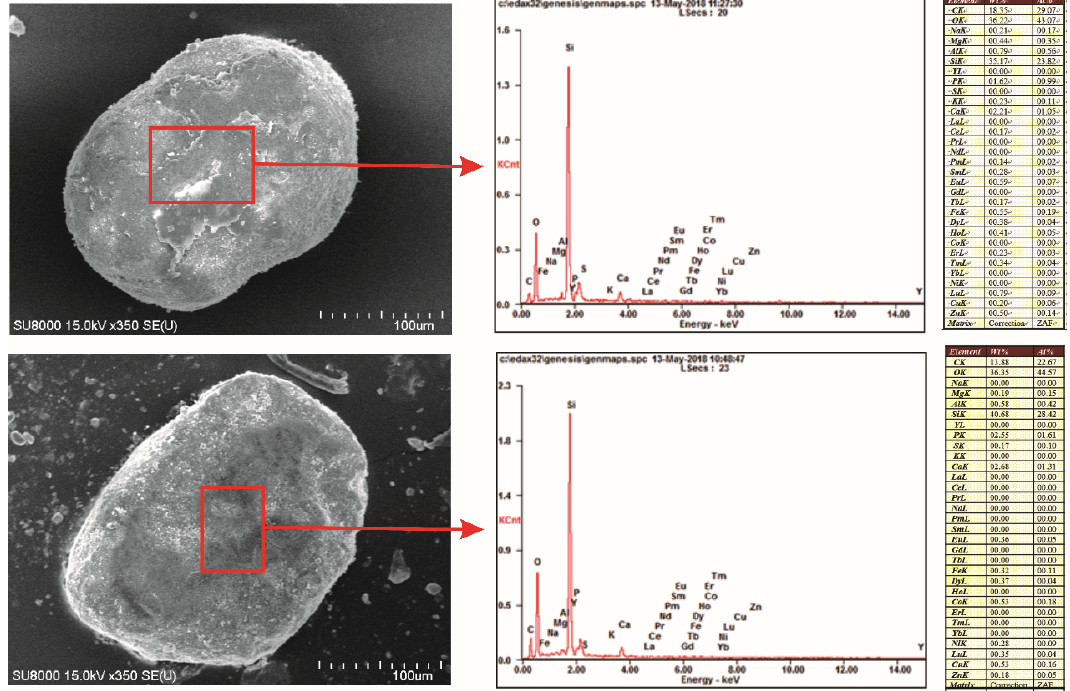
Figure 3. The microstructure and composition of quartz using SEM ‐ EDS analyses.